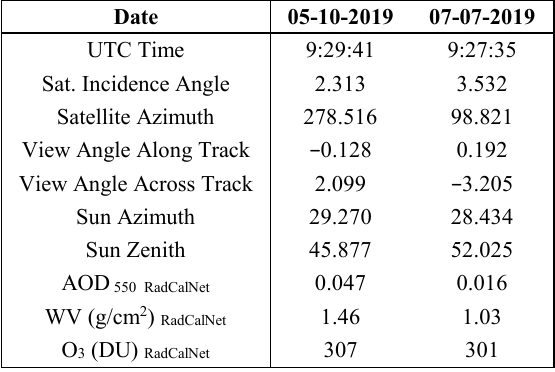
Table 1. Atmospheric retrievals, observation and illumination geometry for the acquisitions over Gobabeb.